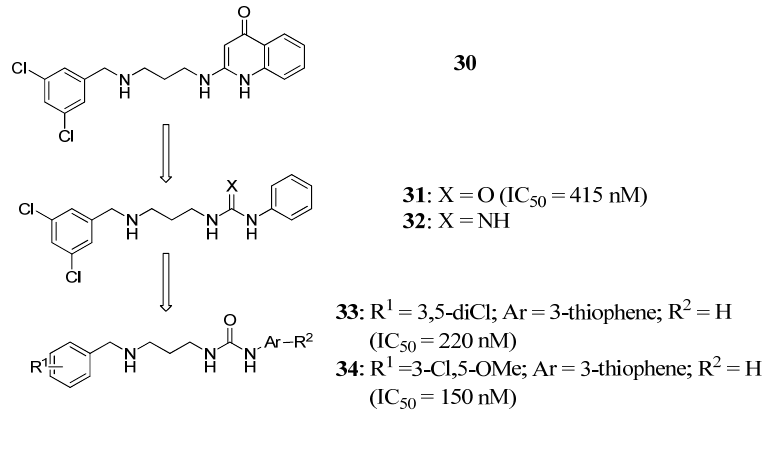
Figure 11. Inhibitor design scheme of Shibata et al. (2012) for IleRS